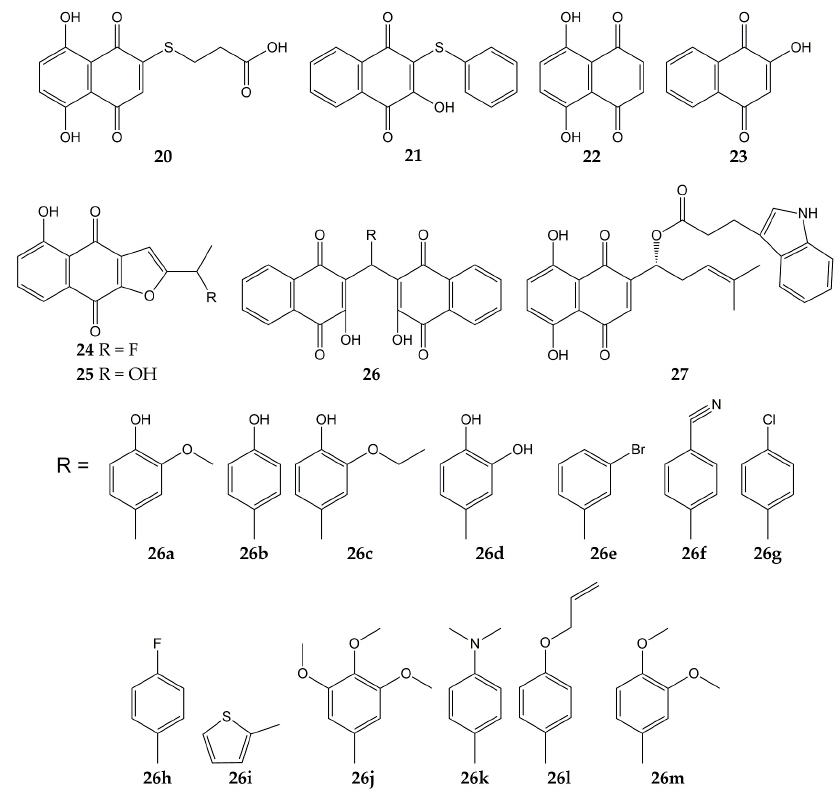
Figure 4. Chemical structures of synthetic naphthoquinones 20 – 27 .